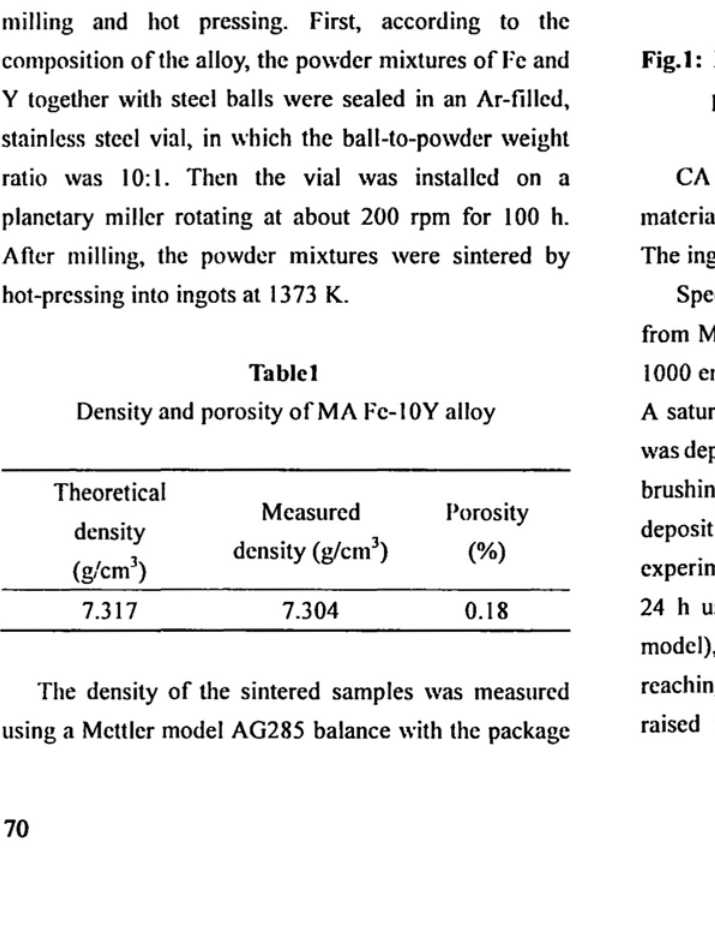
Fig.l: X-ray diffraction patterns for Fe-10Y alloy and powder